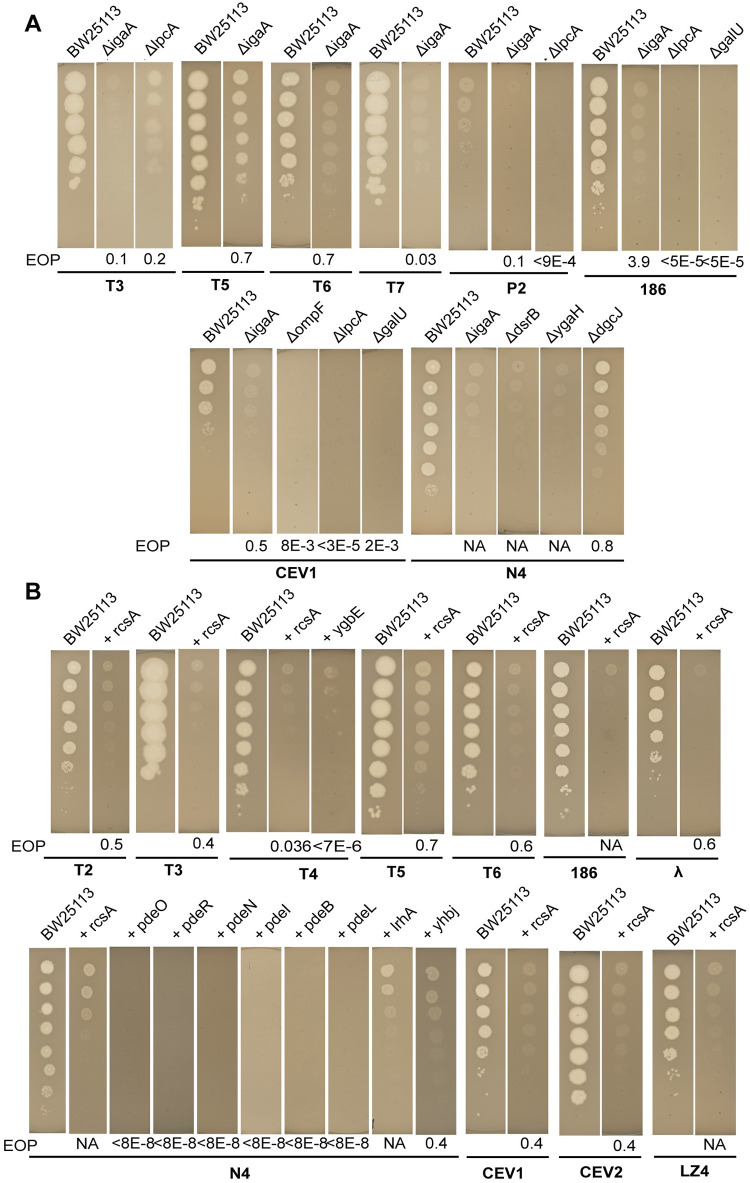
Experimental validations of top-scoring gene hits in LOF and GOF screens.(A) EOP experiments for LOF screen hits using Keio [105,161] library strains. Gene complementation data is presented in S2 Fig. (B) EOP experiments for GOF screen hits with ASKA plasmid library [161] expressing genes (shown as +gene names) in the presence of different phages. We used no IPTG or 0.1 mM IPTG for inducing expression of genes from ASKA plasmid. We used the BW25113 strain with an empty vector for estimating EOP. The plaque morphology or EOP of T3, T7, P2, and 186 phages on lpcA deletion strain indicated inefficient infection. The plating defect was restored to normal when mutants were complemented with a plasmid expressing the respective deleted genes indicating LPS core as the receptor for these phages (S5 Fig). EOP, efficiency of plating; GOF, gain-of-function; LOF, loss-of-function; LPS, lipopolysaccharide.